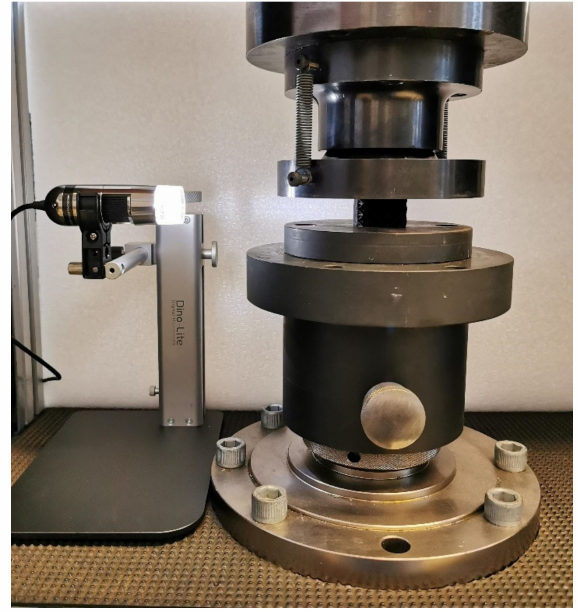
Figure 3. Compression test